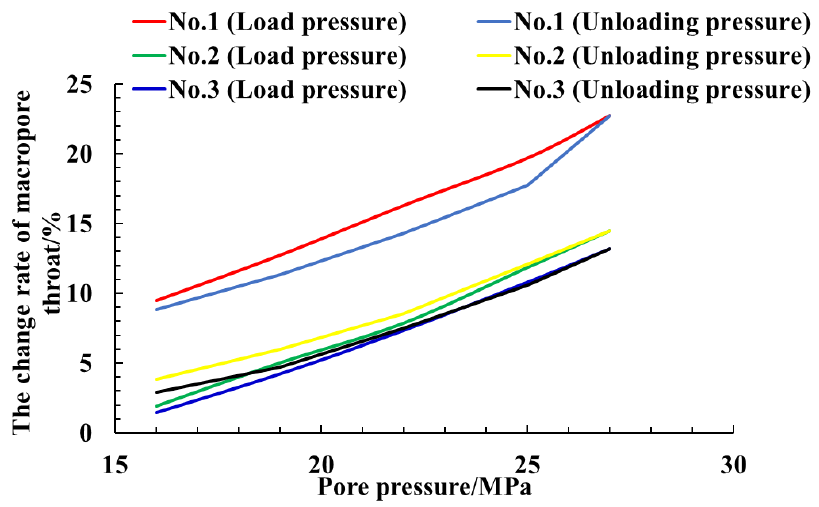
Figure 4. The change rate of macropore throats with different pore pressures of matrix samples.